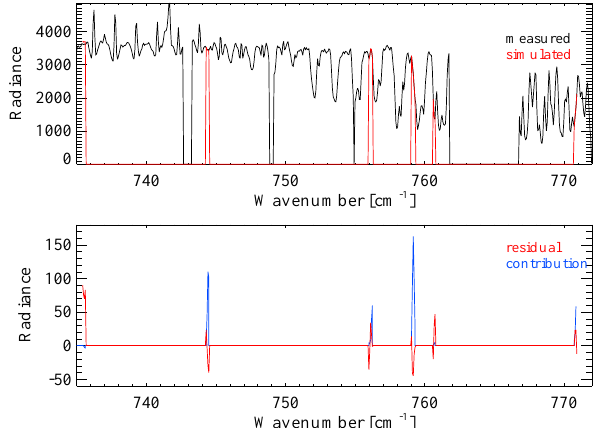
Fig. 6. As Fig. 2 but for HCN. The RMS difference for the shown set of microwindows is 40.0nW/(cm 2 srcm − 1 ).